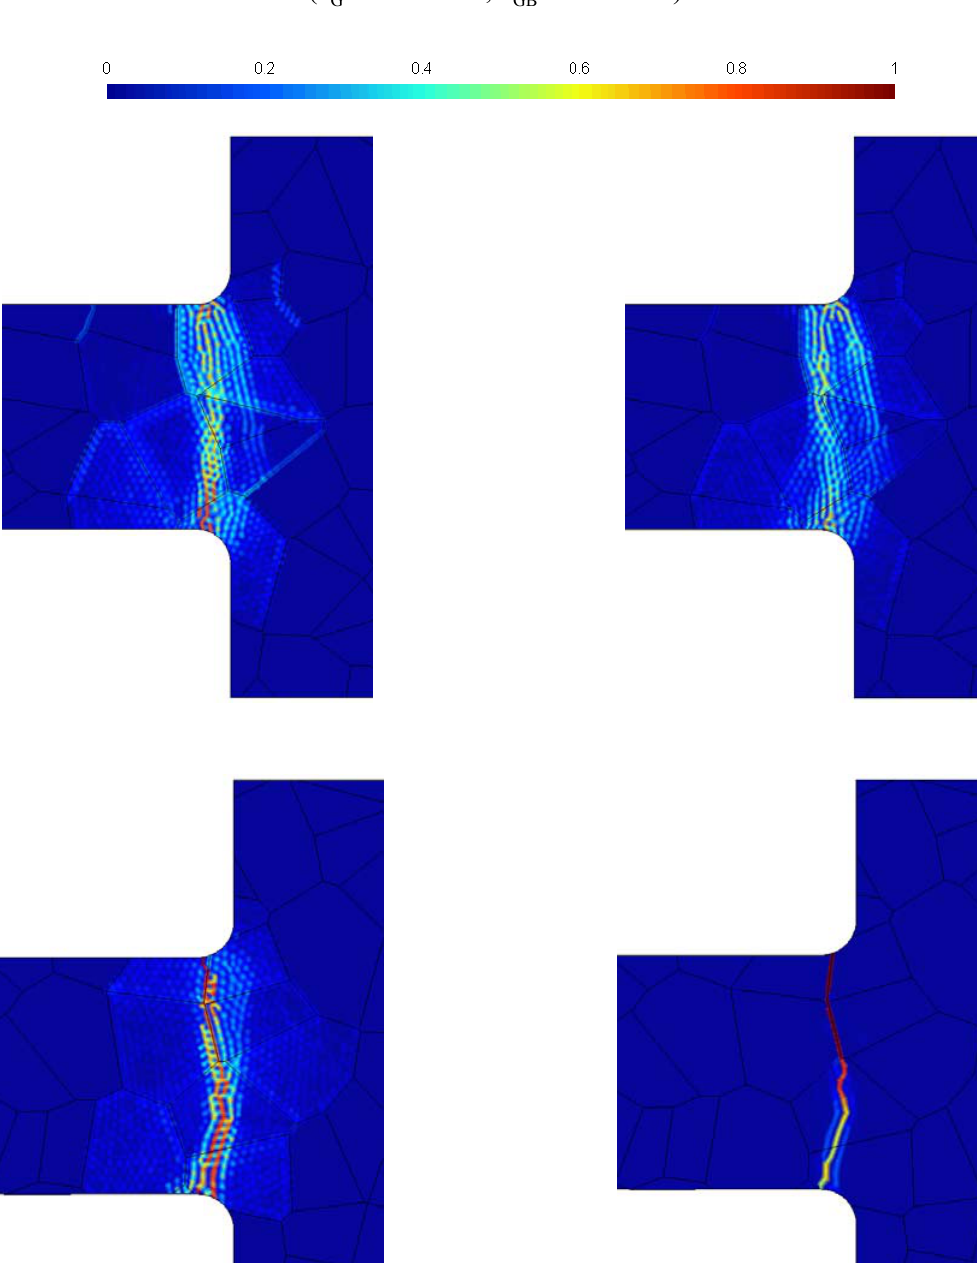
Figure 8. Statistical forecast of the cohesive zone at failure. Top row: micro-structure A; bottom row: micro-structure B. Left column: perfect GBs ( 5.2 right column: defective GBs ( 5.2